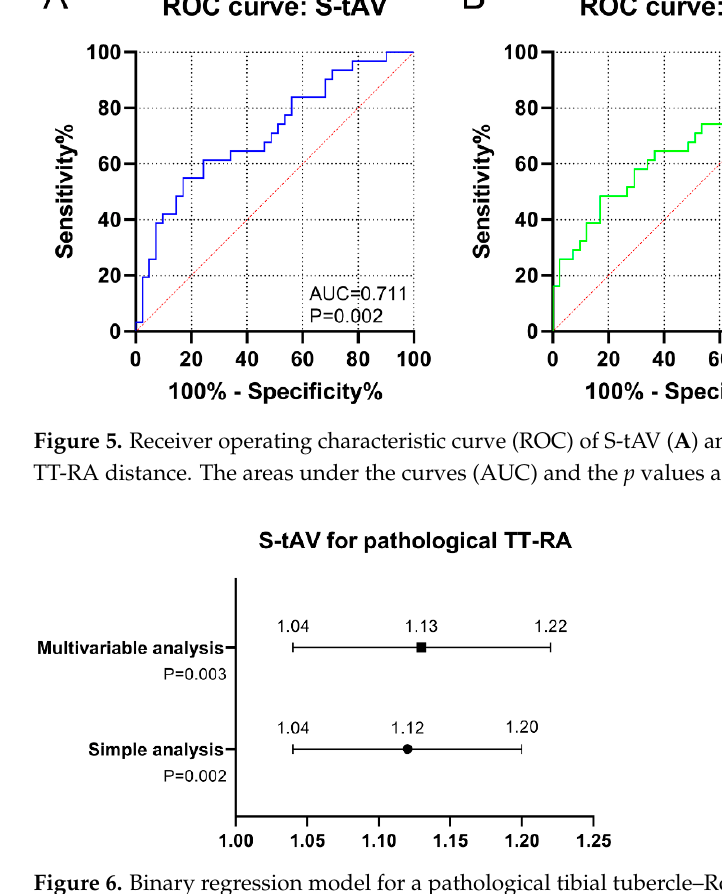
Figure 6. Binary regression model for a pathological tibial tubercle–Roman arch distance. The odds ratio, 95% confidence interval, and p values are shown.